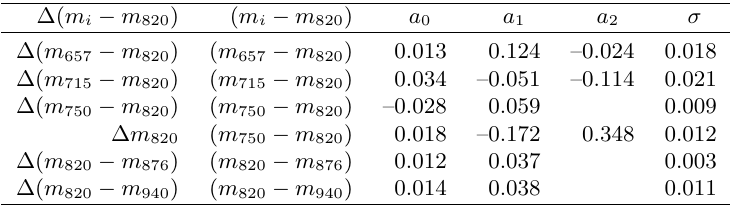
Table 3. Coefficients of Equation (2) and the accuracy of decontamination corrections for six passbands constructed from the simulated Gaia RP spectra for M-type stars of different luminosities without interstellar